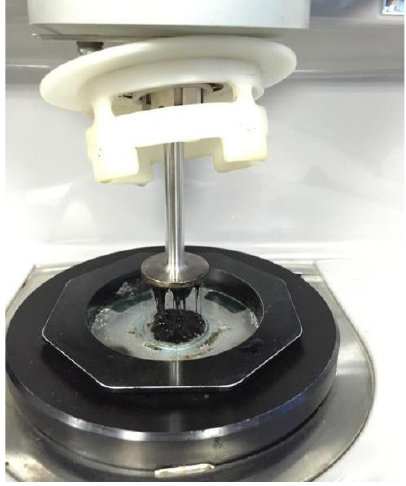
Figure 2. Fiber-reinforced CA samples after RCRT.